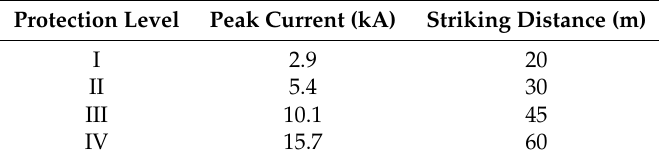
Table 3. Peak current and strike distance by protection levels